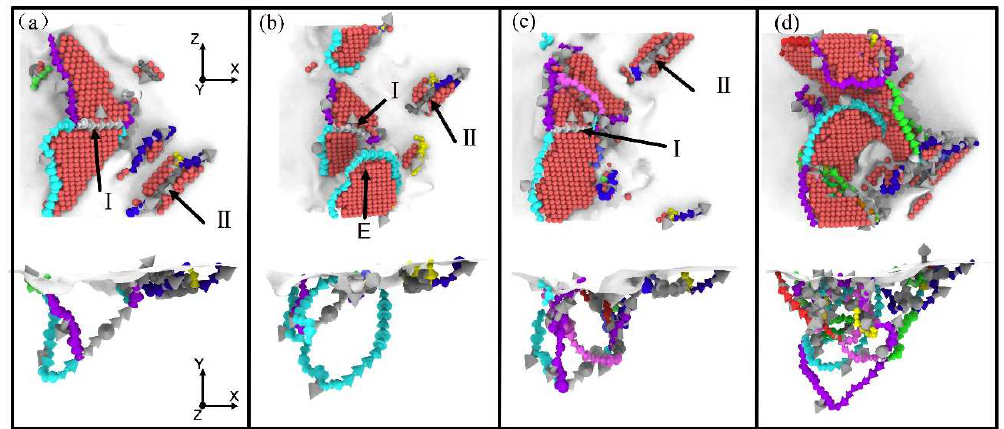
Figure 7. Formation process of a dislocation tangle in the plow machining state. The machining distances in ( a – d ) are 12, 13, 14, and 20 nm, respectively. Here, indigo, pink, gray, blue, purple, and yellow represent Shockley, perfect, stair-rod, Frank, Hirth, and other dislocations, respectively. As displayed in Figure 8, the dislocation evolution during the formation of a disloca- tion tangle was quantitatively studied, and the change rules of the number, average length, and density of dislocations in the subsurface during machining were analyzed. It can be seen from Figure 8a that the number of dislocations increased with the machining distance, the number of Shockley partial dislocations was large, and the growth rate was fast. Conversely, the number of stair-rod and Hirth dislocations formed by the Shockley